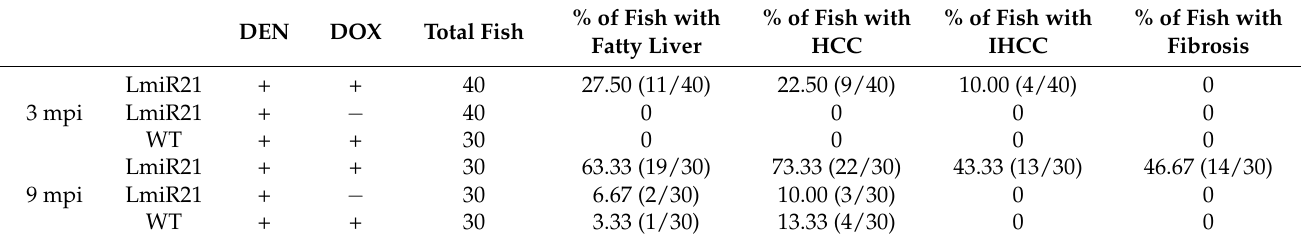
Table 1. Incidents in the livers of DEN-treated zebrafish.